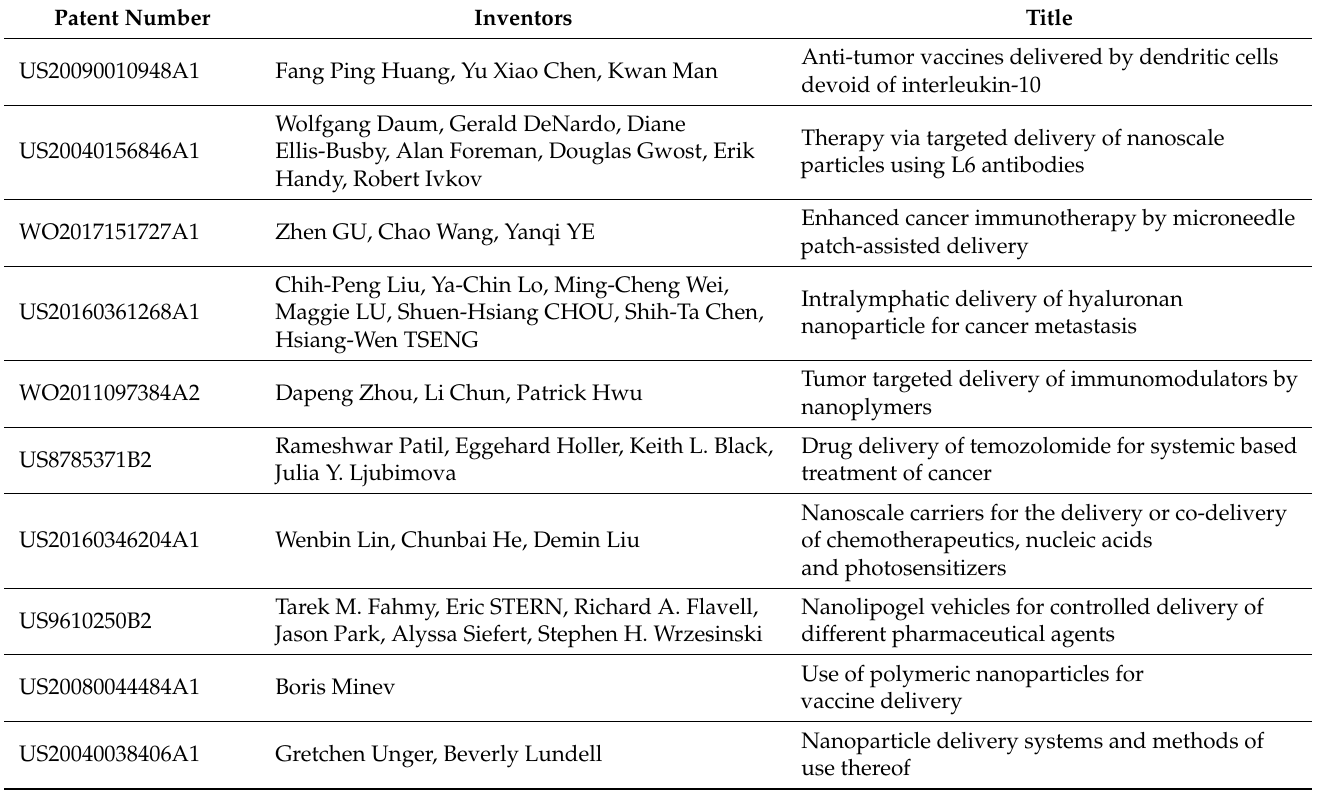
Table 6. Novel patents for cancer immunotherapy by various delivery